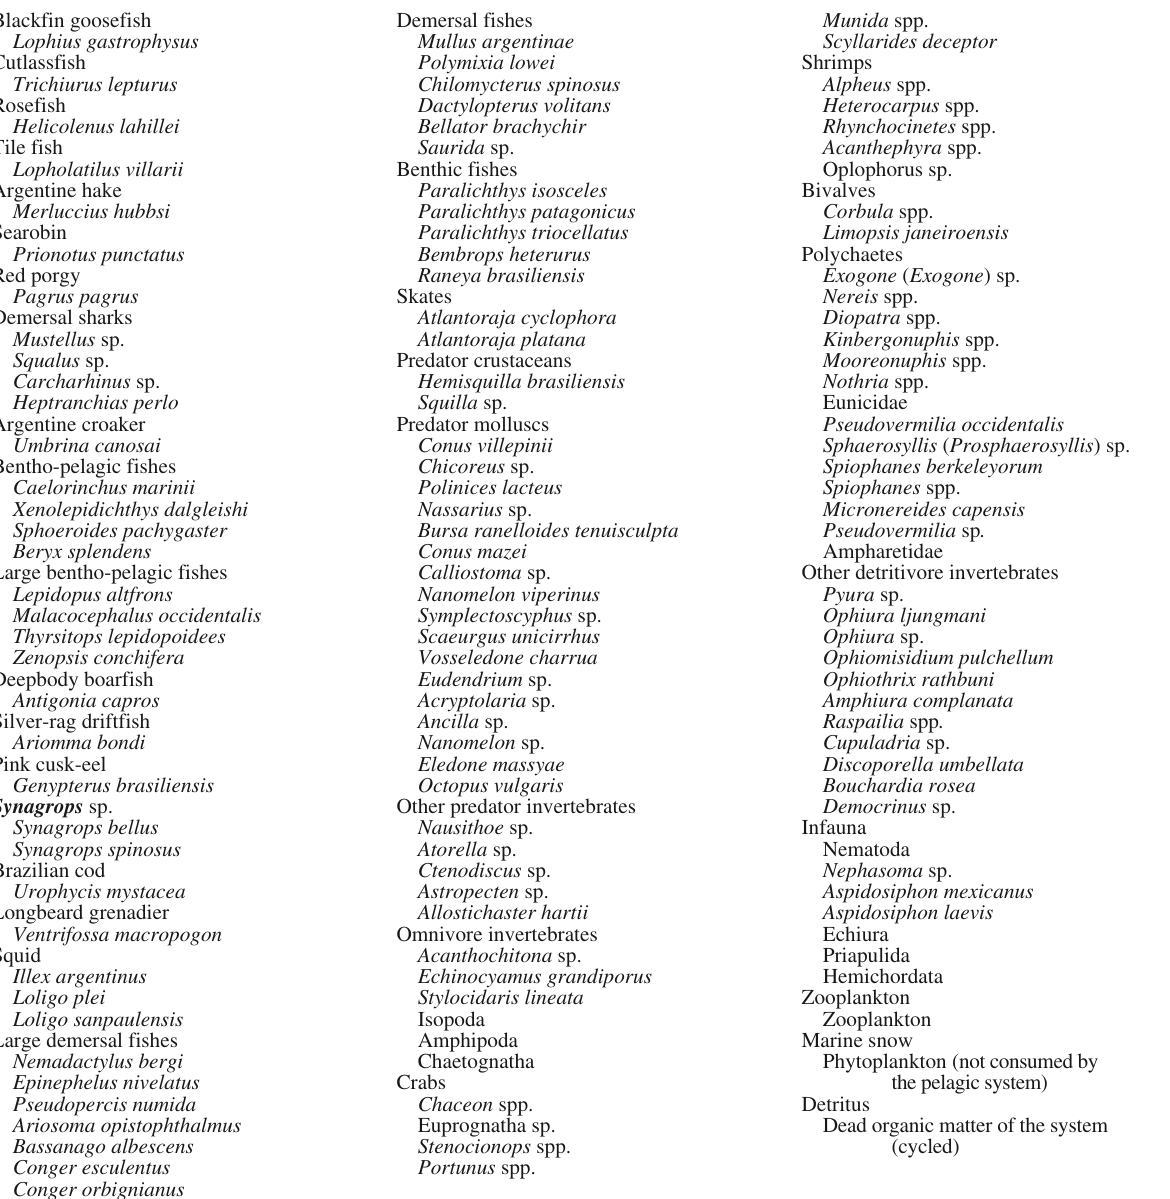
Table 1. – Name and main components of each functional